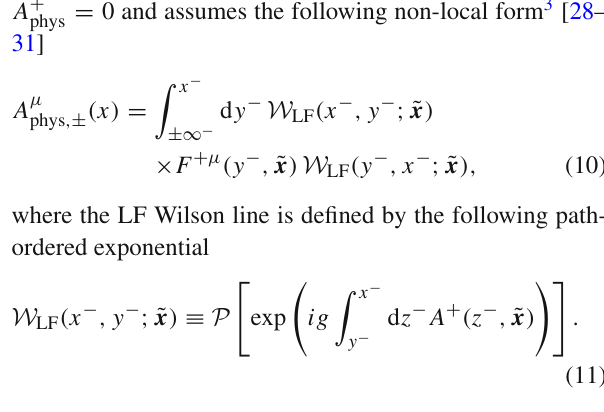
μ ( 0 ) ≡ A μ ( 0 ) viaEq.(13)foranarbitrary pure ,η C